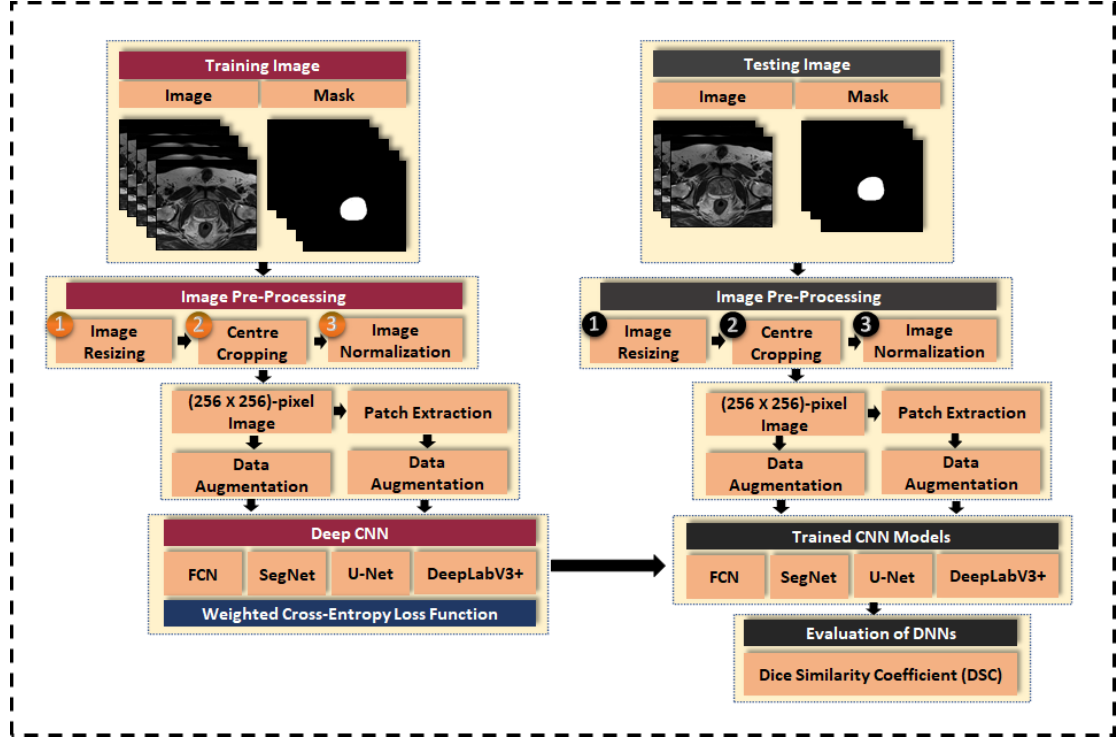
Figure 1. General methodology for evaluation of encoder–decoder CNN architectures in semantic segmentation of prostate T2W